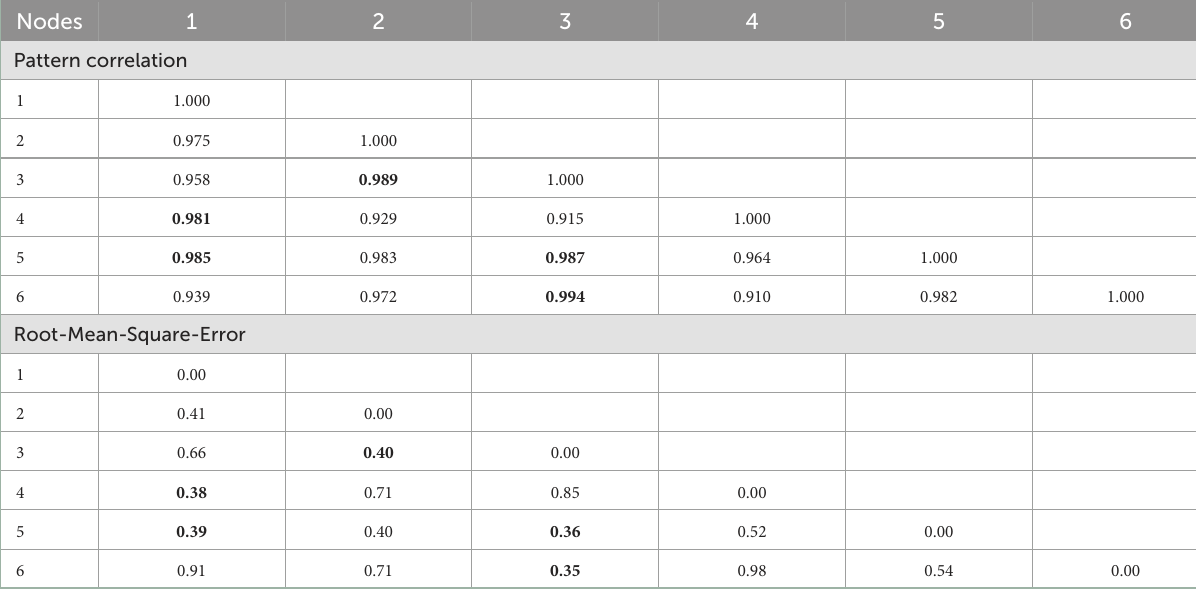
TABLE 3 Pattern correlation (top) and root-mean-square-error (bottom) between SOMs nodes of the composite of rainfall anomalies in Figure 3A.